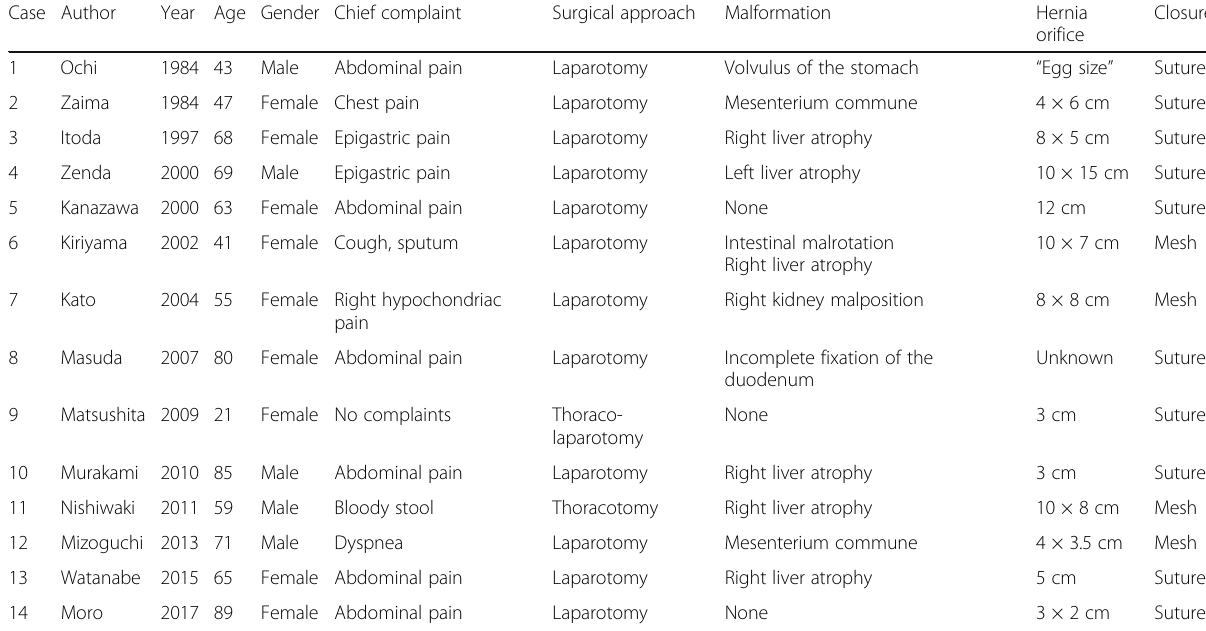
Table 1 Summary of the reported cases of adult right sided Bochdalek hernia in Japan Case